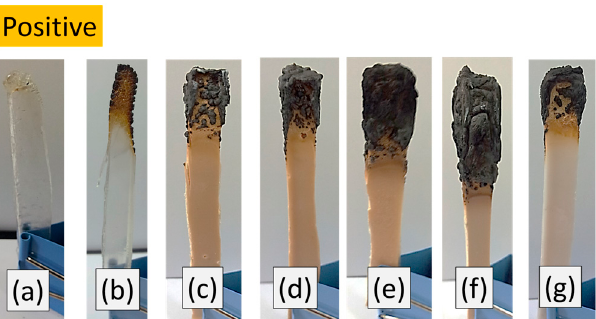
Figure 5. Residues after burning for 1 min: ( a ) pure PU; ( b ) Si-PU; ( c ) Si-PU/OFMPP 10%; ( d ) Si-PU/OFMPP 20%; ( e ) Si-PU/OFMPP 30%; ( f ) Si-PU/OFMPP 40% and ( g ) Si-PU/MPP 30%.